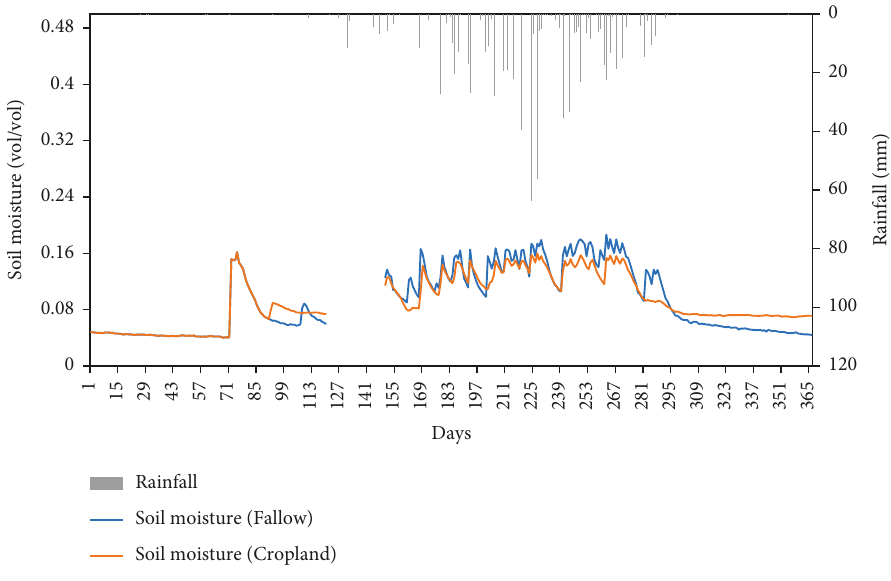
Figure 8: Soil moisture recorded under cropland and fallow